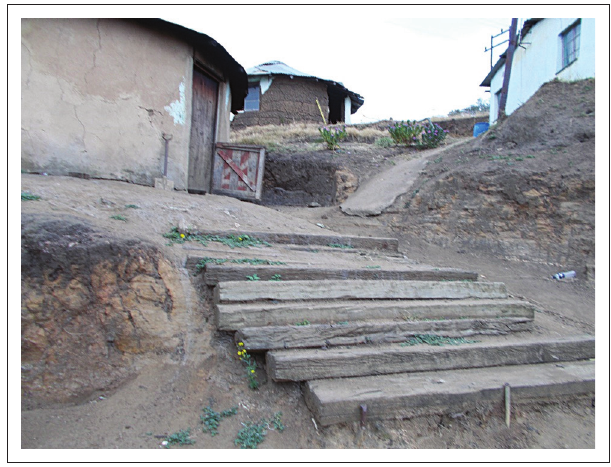
FIGURE 1: Wheel chair inaccessibility, an example of the terrain surrounding one of the homes of a person with physical disability, which limits this person’s ability to be independent in mobilising around the